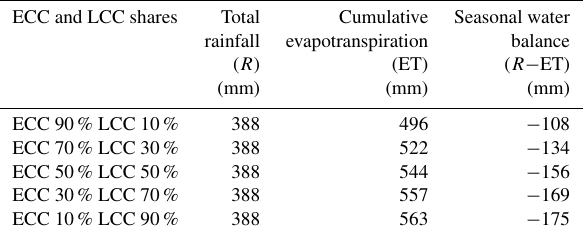
Table 9. Weather data and simulation results of Noah-MP LSM for cumulative evapotranspiration for the Kraichgau region. Simula- tions were performed considering different shares of early-covering crops (ECC) and late-covering crops